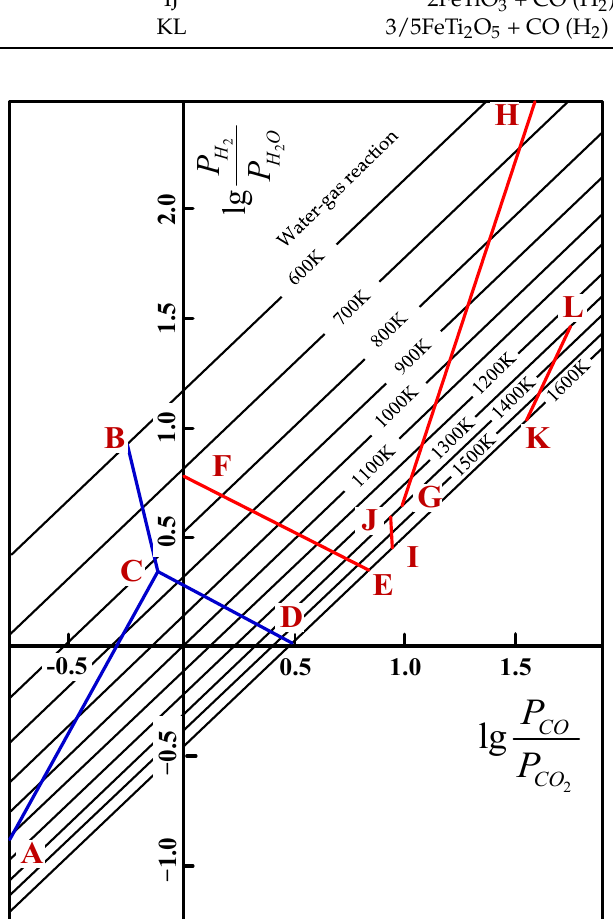
Figure 5. Equilibrium diagram of reducing titanium and iron oxides in C-H-O system [24].